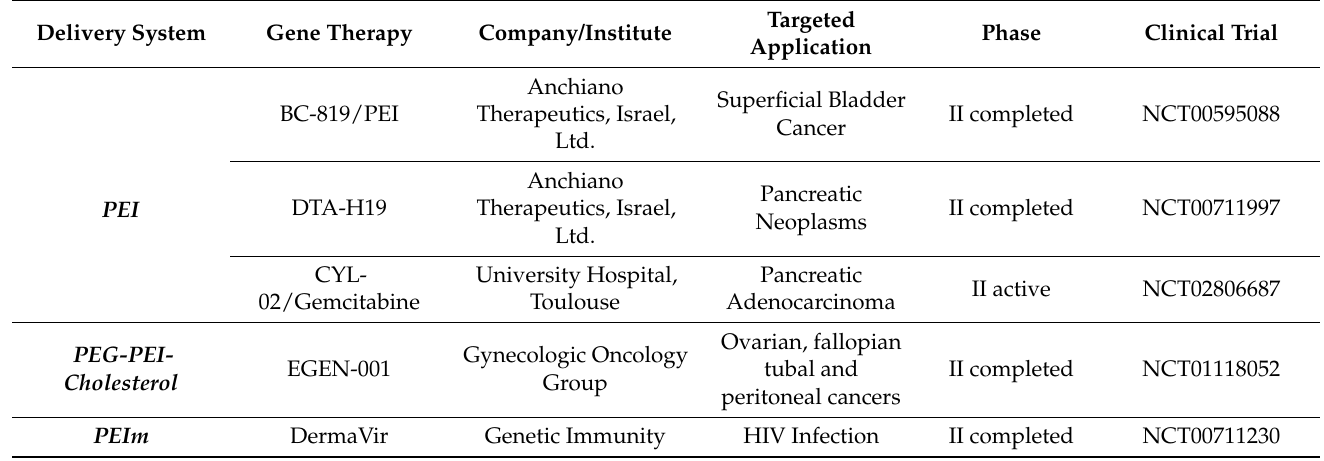
Table 2. PEI-based non-viral vectors under clinical